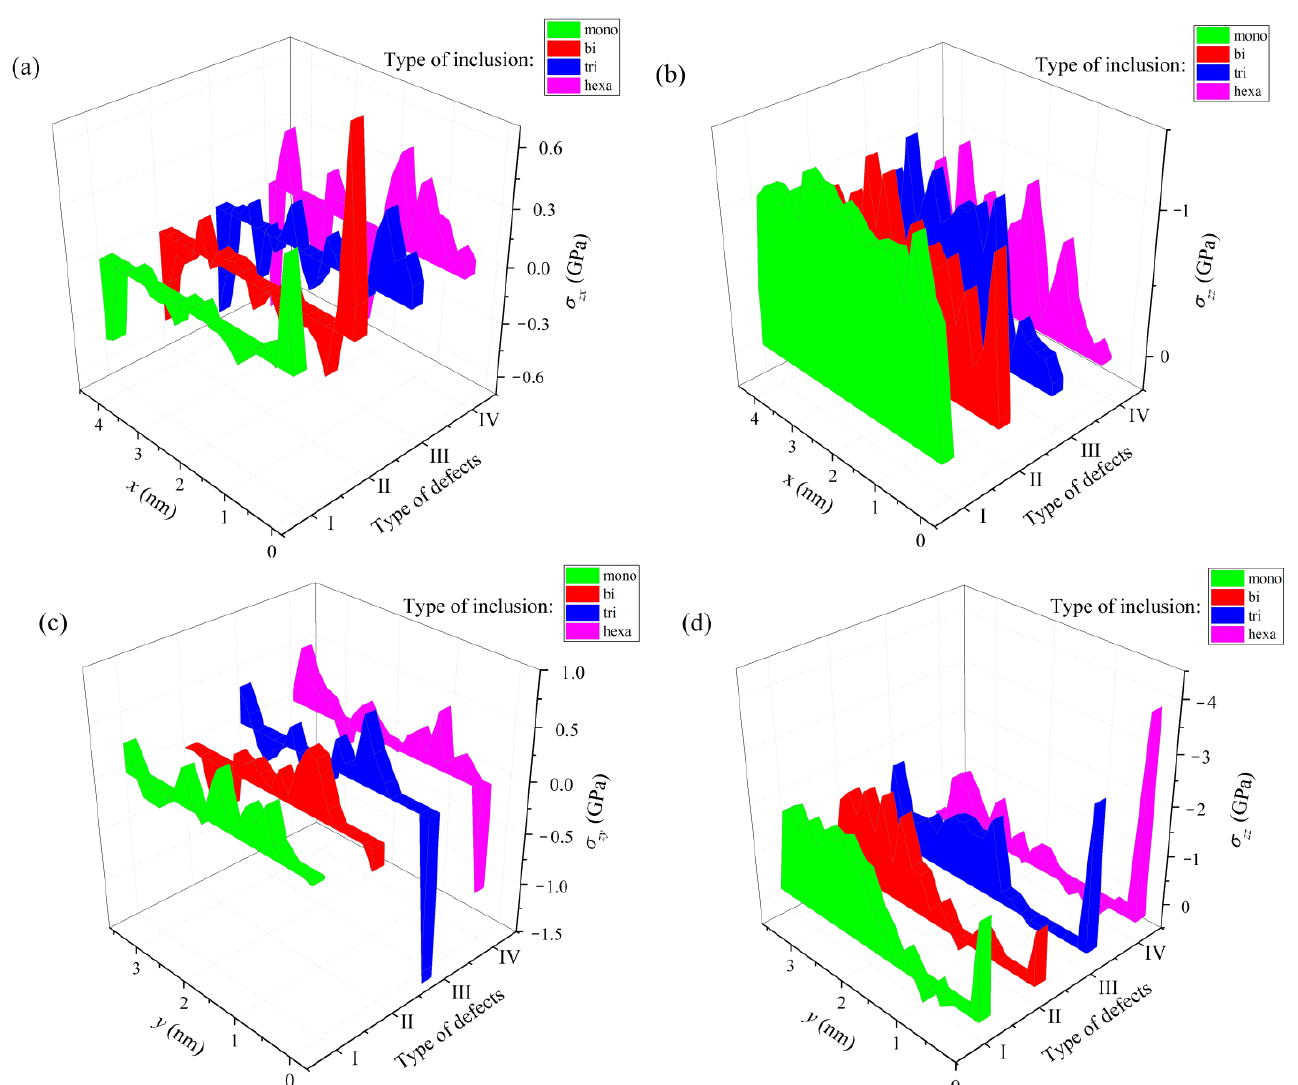
Figure 16. Stress distribution in a lithium-intercalated silicene channel with defects initially filled with P atoms; the channel with a gap of 0.24 nm is located on a graphite substrate, which has 5% doping with nitrogen; ( a , b ) show the distribution of stresses σ zx and σ zz along the direction 0 x (zig-zag); ( c , d ) show the distribution of stresses σ zy and σ zz along the direction 0 y (armchair); types of defects filled with P atoms: I, mono-, II, bi-, III, tri-, and IV—hexavacation. Reprinted with permission from Ref. [46]. 2020, Springer.